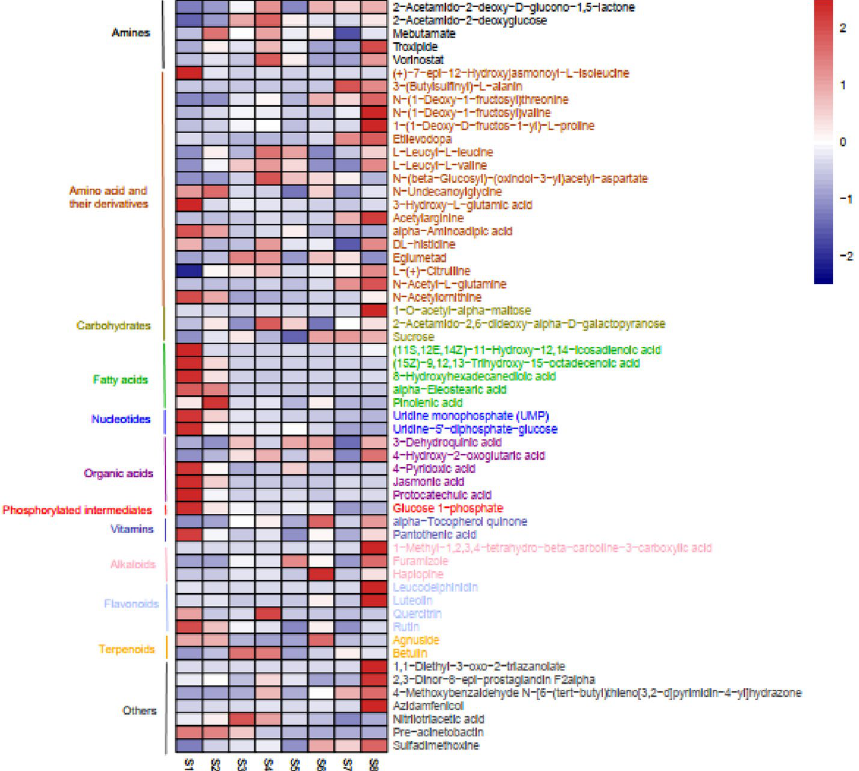
Figure 4. Heatmap of the 57 differential